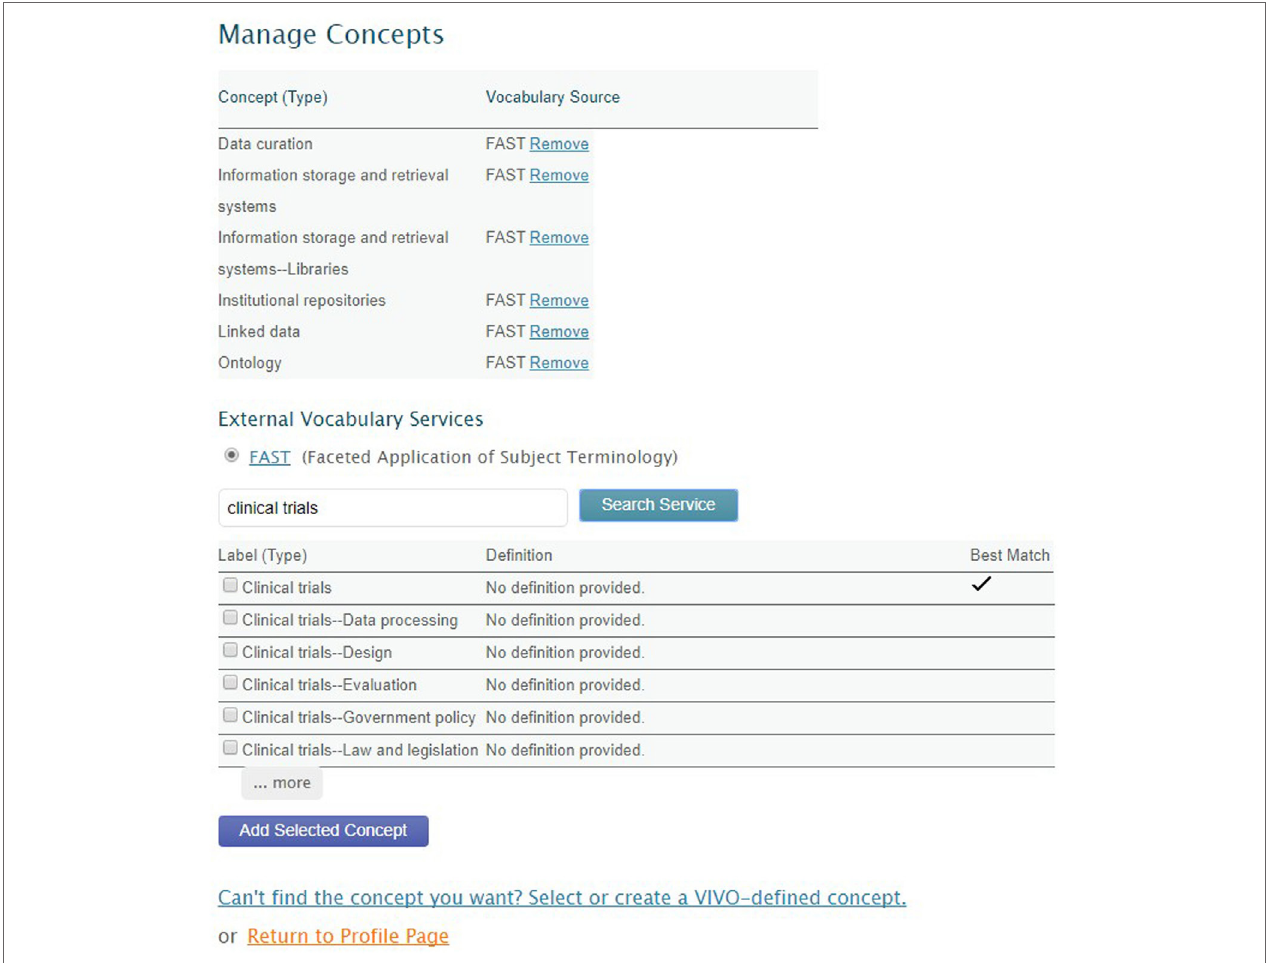
FIguRe 4 | Selection of concepts from FAST to add to an OpenVIVO profile.